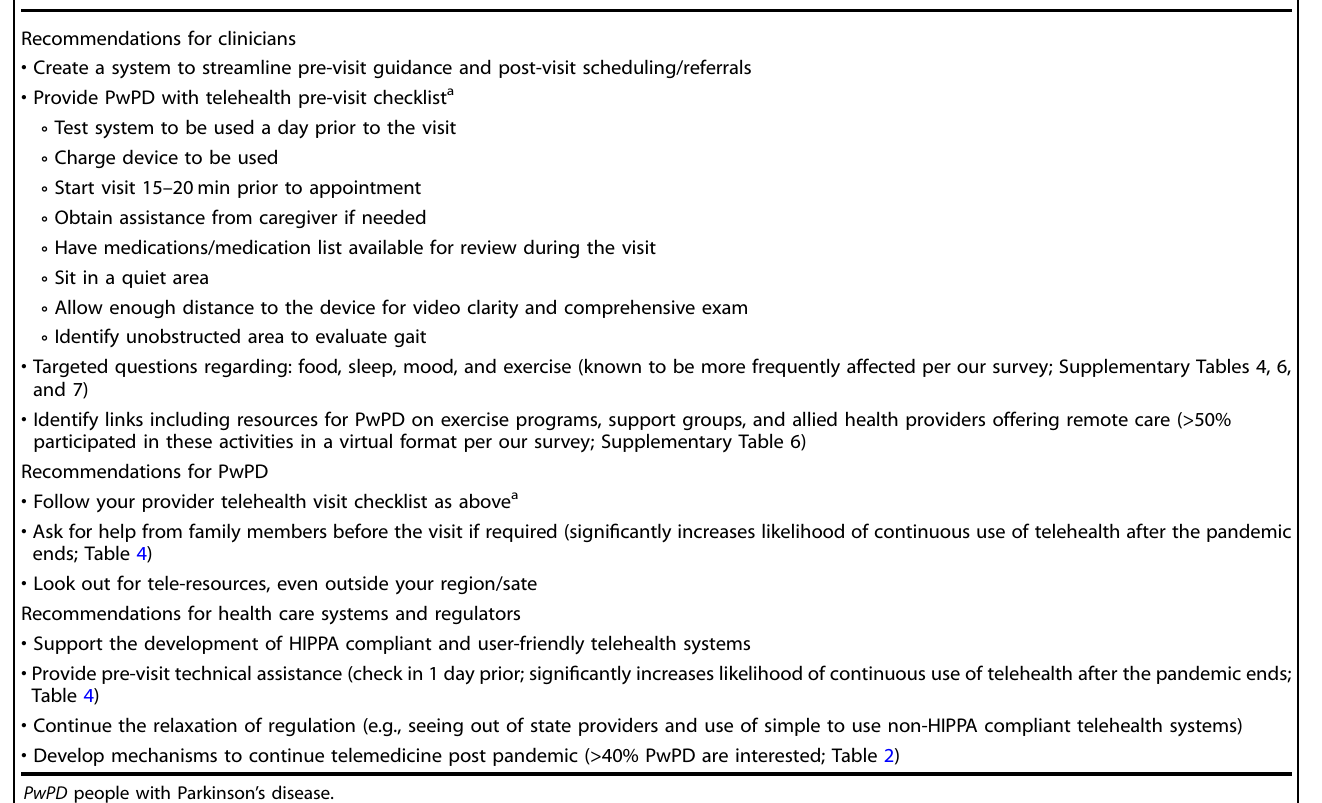
Table 6. Recommendations for better care during